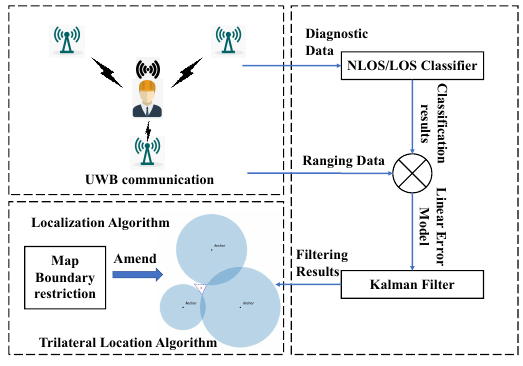
Figure 1. Frame diagram of our positioning system.